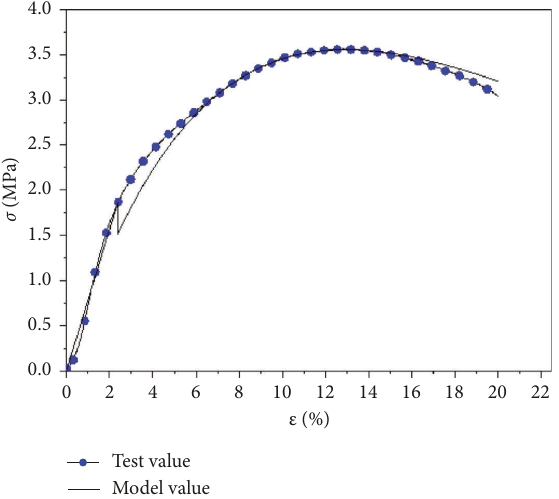
Figure 14: Comparison of model values and test values at − 15 ° C.